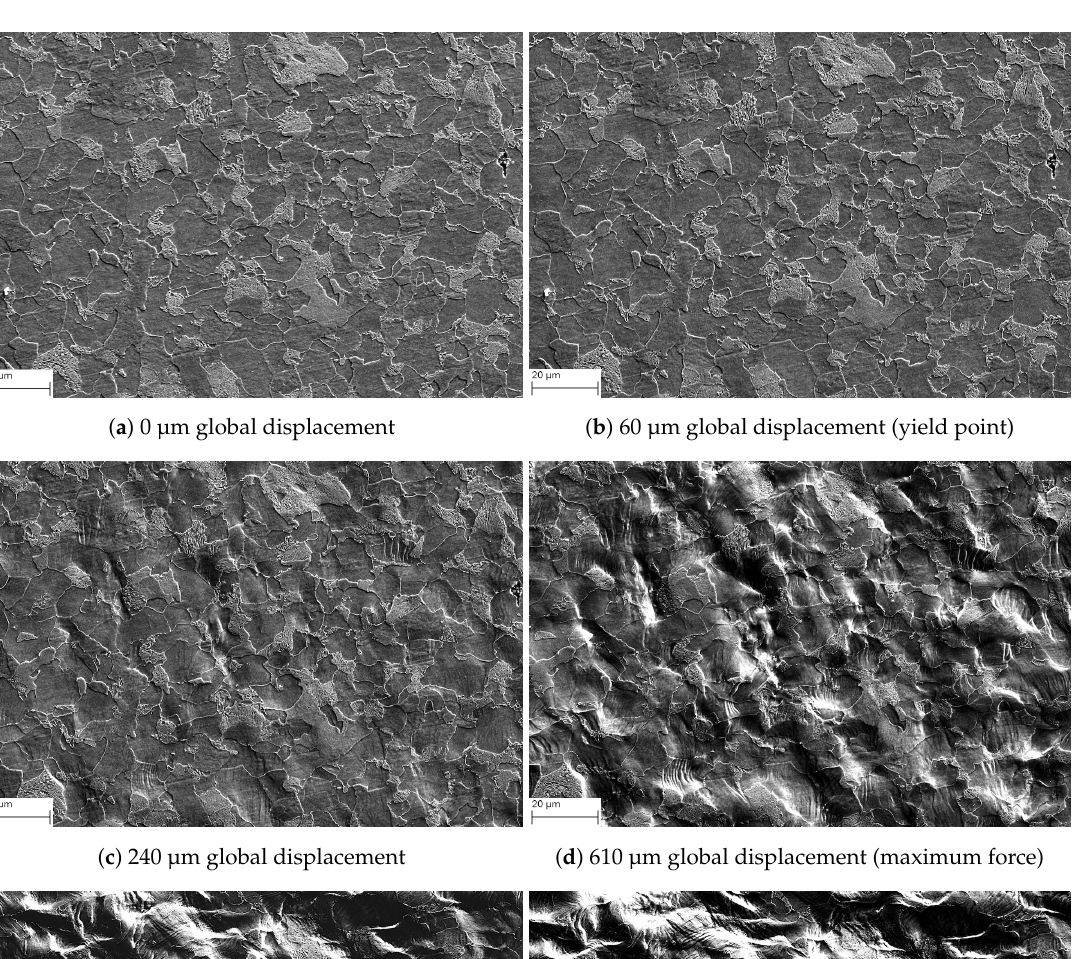
Figure 8b. Then, bands start to form in Figure 8c during the work-hardening stage. After the formation of these bands, nearly all subsequent deformation takes place inside the localized zones. Next to the heavily deformed bands, there is little deformation. Some places these bands cut through pearlite grains, but for the most part, the less deformed (blue) regions in the strain field are pearlite grains.